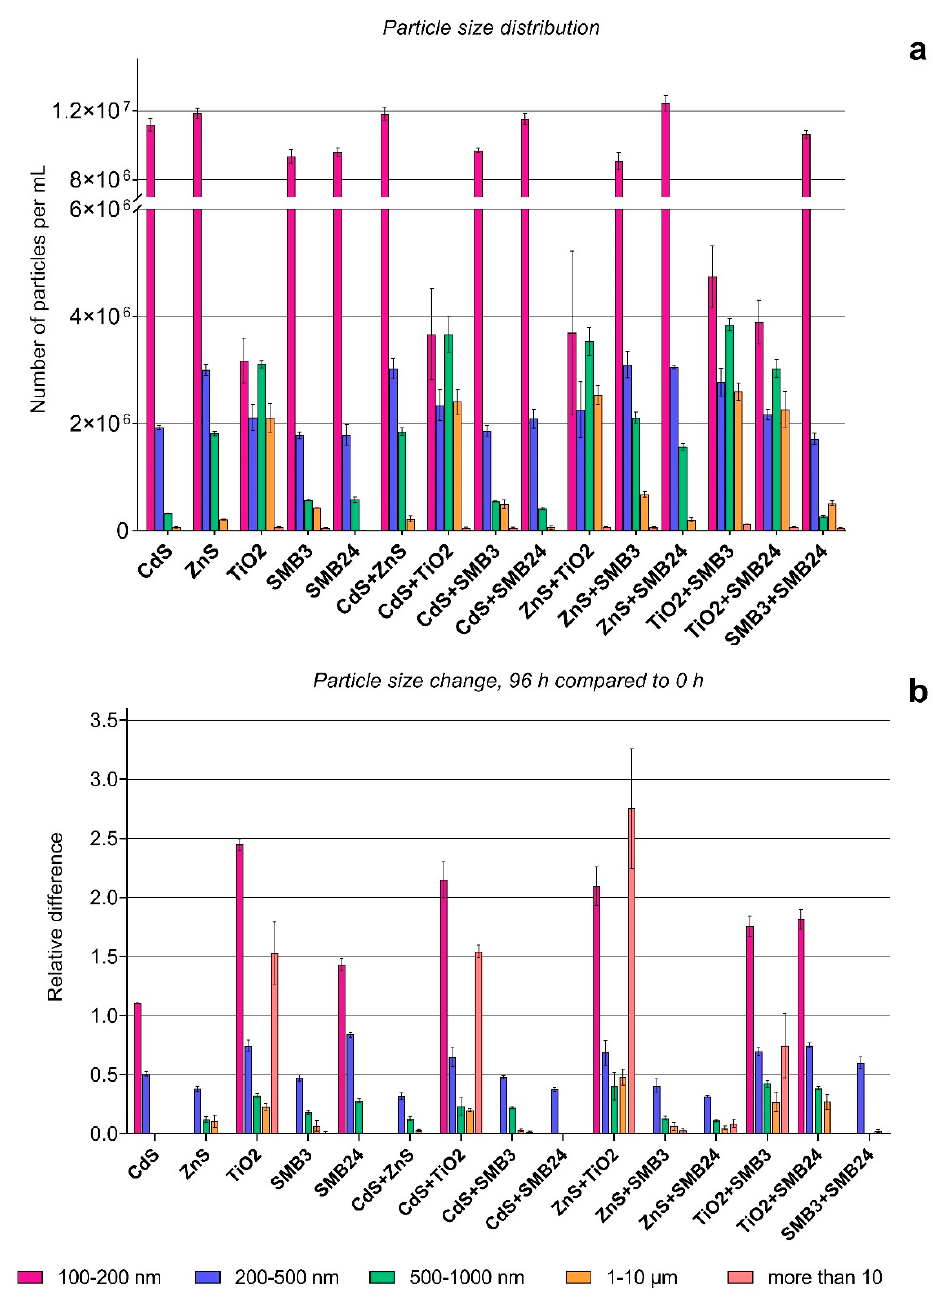
Figure 4. Particle size distribution and size change with time. ( a ) Size distribution of NPs after dispersion. ( b ) Relative particle size change after 96 h compared with 0 h. The values higher than 1.0 mean surpassing the experimental group compared with the reference group, and the values below 1.0 mean a corresponding reduction in the experimental group compared with the reference group (the lower value, the higher the reduction). Statistically insignificant results ( p > 0.05) are not represented on the graph.